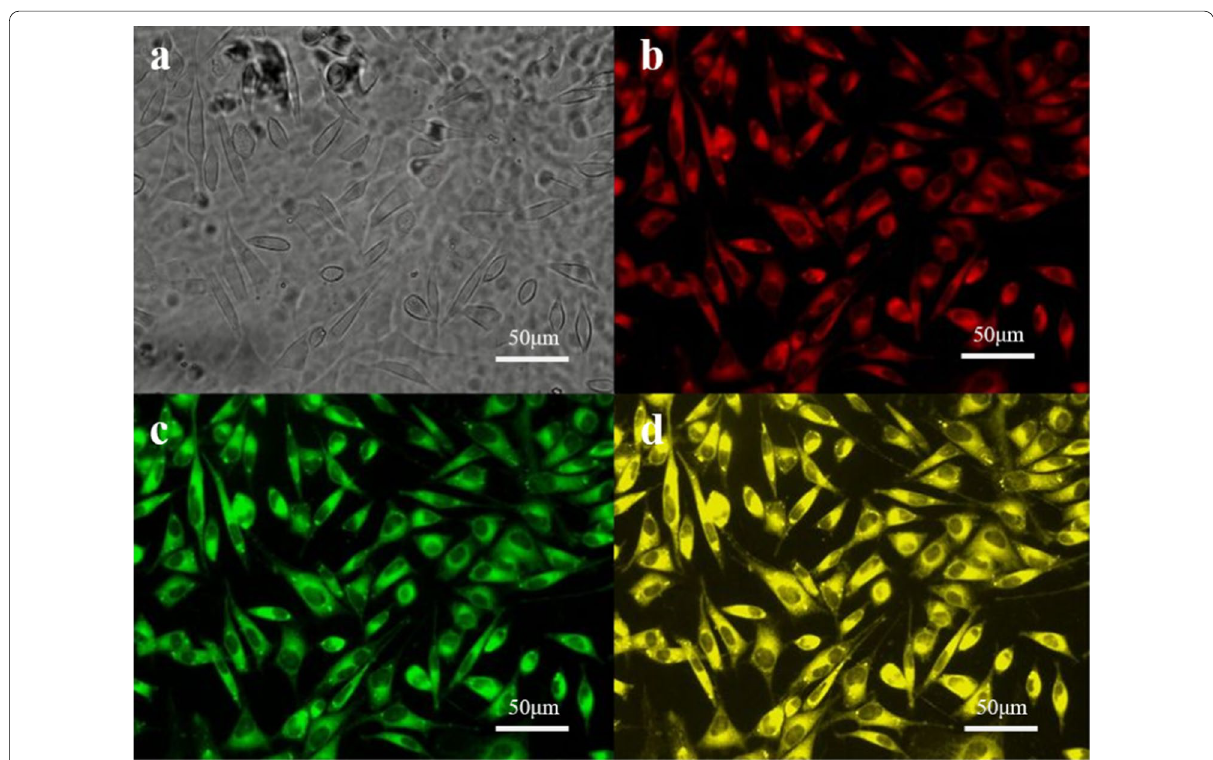
Fig. 2 Photographs of LoVo cells after 2 h of staining with NPs loaded with rhodamine B and coumarin-6 (200 under the light microscopy, b cell morphology under fluorescence microscope(PI fluorescence channel), c cell morphology under fluorescence microscope(FITC fluorescence channel), and d cell morphology under fluorescence microscope(PI/FITC dual fluorescence